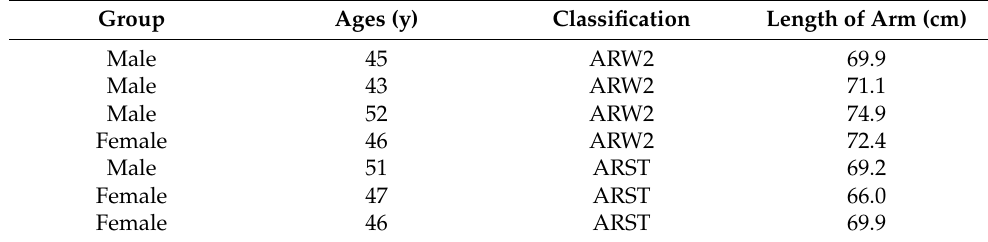
Table 1. Characteristics of participants.